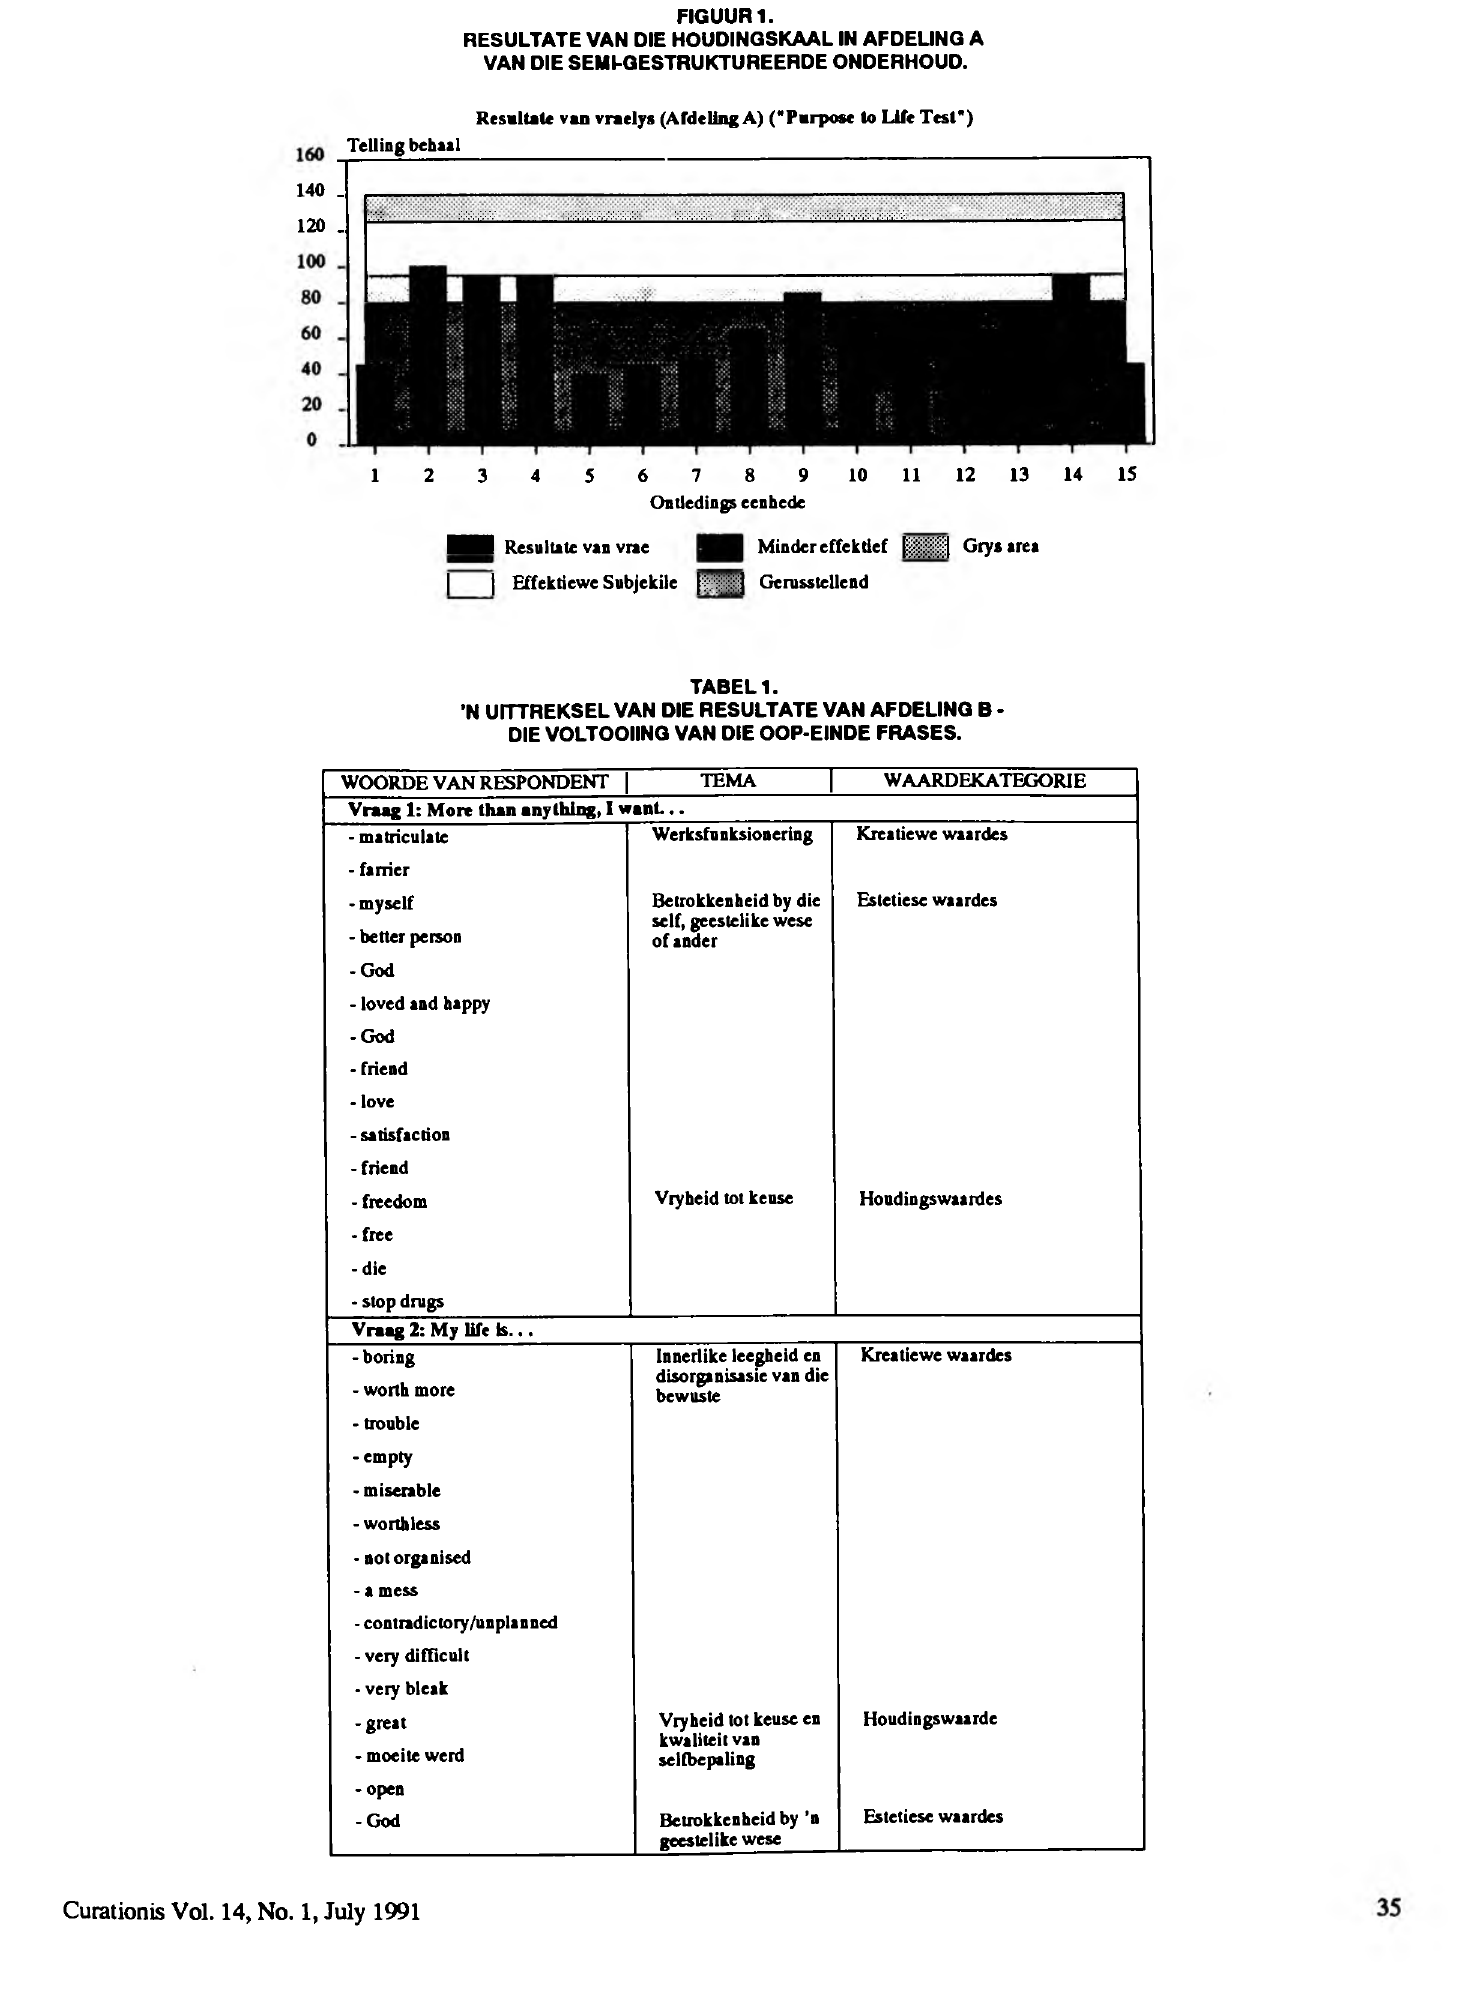
FIGUUR1. RESULTATE VAN DIE HOUDINGSKAAL IN AFDELING A VAN DIE SEMI-GESTRUKTUREERDE ONDERHOUD.